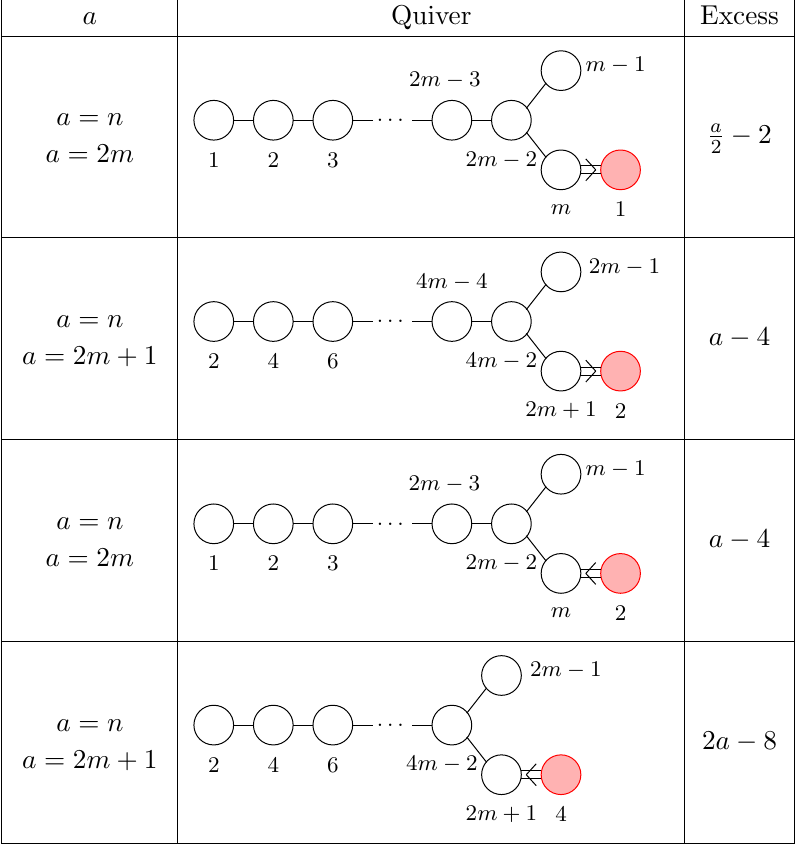
Table 15 . Exotic minimally unbalanced quivers with G = SO(2 n ) and a double laced edge. outwards and inwards from the unbalanced node, respectively. Tables 26 and 27 collect quivers with a triple laced edge directed outwards and inwards from the unbalanced node,